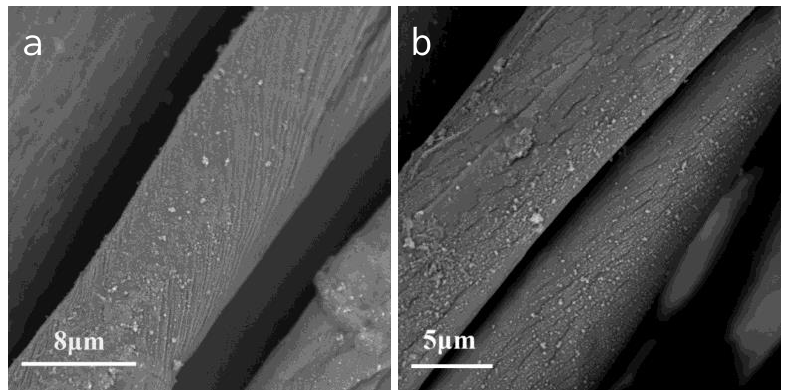
Figure 9. SEM images of O 2 plasma treated sample ( a ), and treated samples after standard washing ( b ).